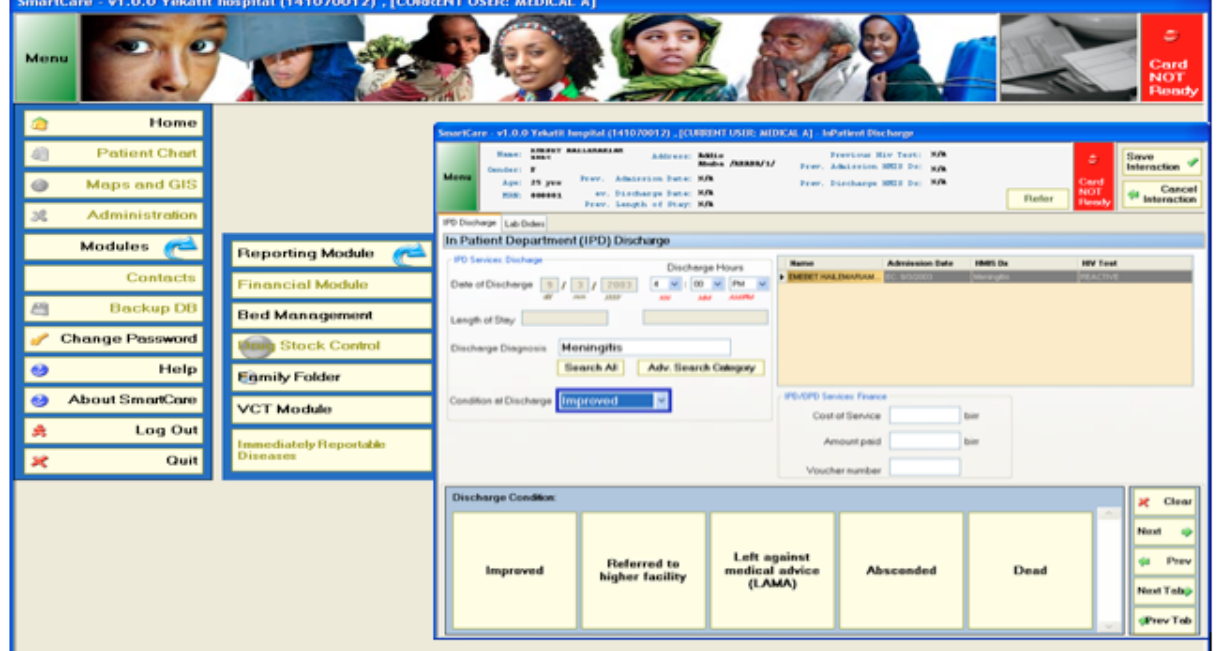
Figure 1. Screenshot of the SmartCare EMR system currently implemented in Ethiopian hospitals. The main modules are listed on the left side of the image. The main modules have sub-modules that will be displayed upon clicking. The screenshot shown is displayed when "bed management" is